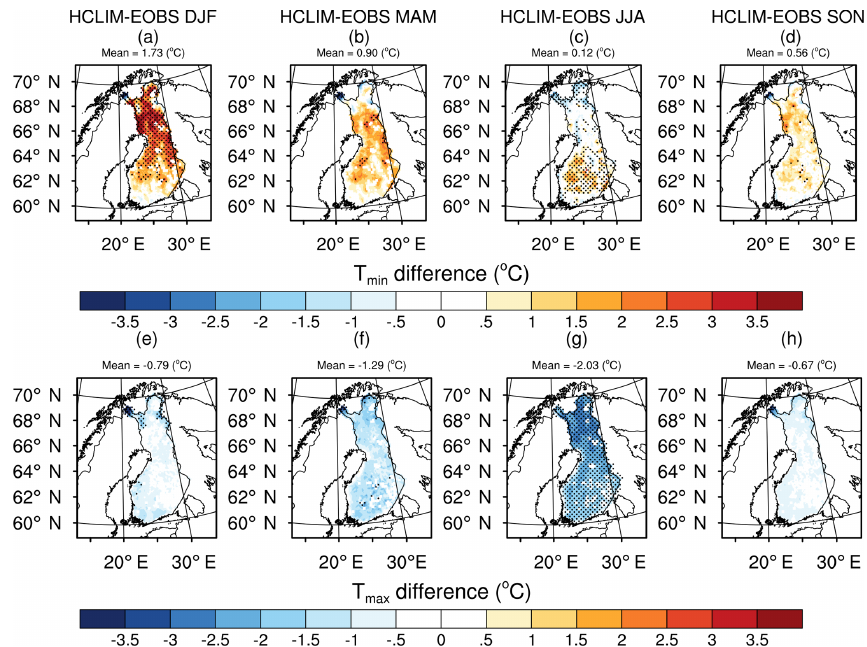
Figure 5. The biases in the simulated seasonal means of (a–d) minimum near-surface air temperature ( T min ) and (e–h) maximum near- surface air temperature ( T max ) with a reference to E-OBS. The seasonal mean biases were calculated over Finland for the time period of January 2002–December 2014. Stippled areas represent statistically significant differences with p values < 0 .